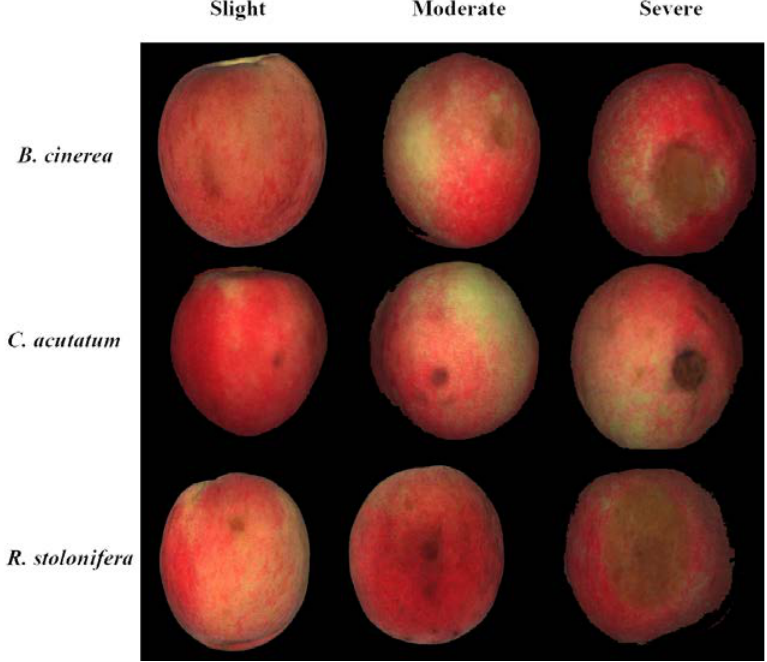
Figure 3. RGB images of the three kinds of diseases at each level of decay.